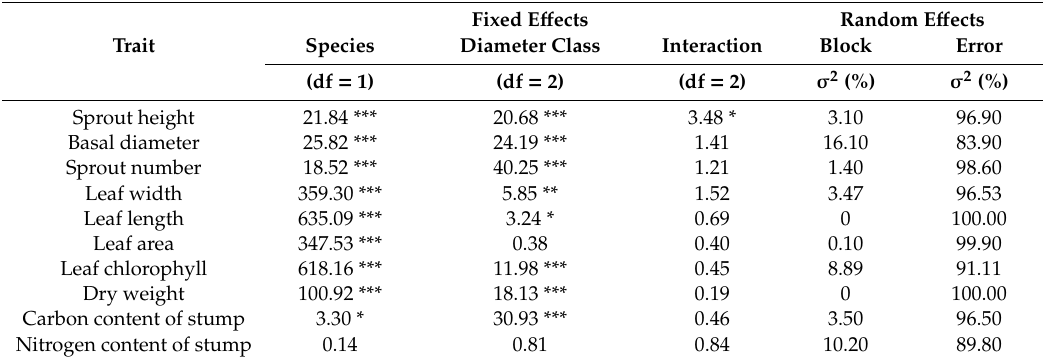
Table 2. Mixed model ANOVA results for growth variables, including source of variation, degrees of freedom (df), and